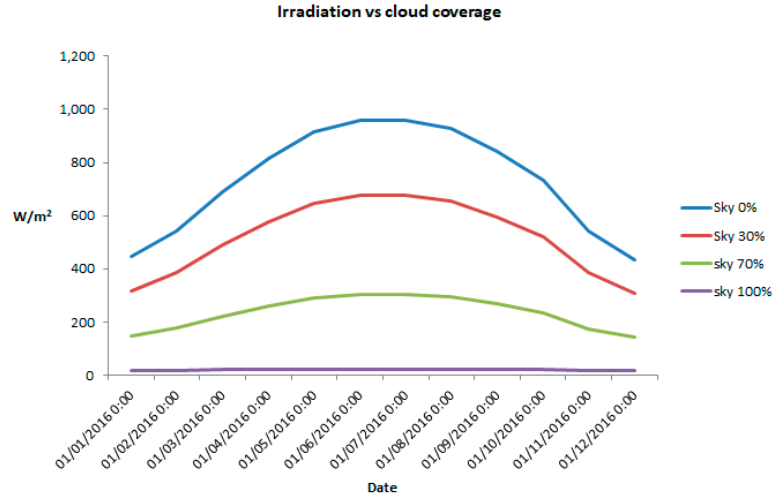
Figure 4. Solar tracker estimator results.